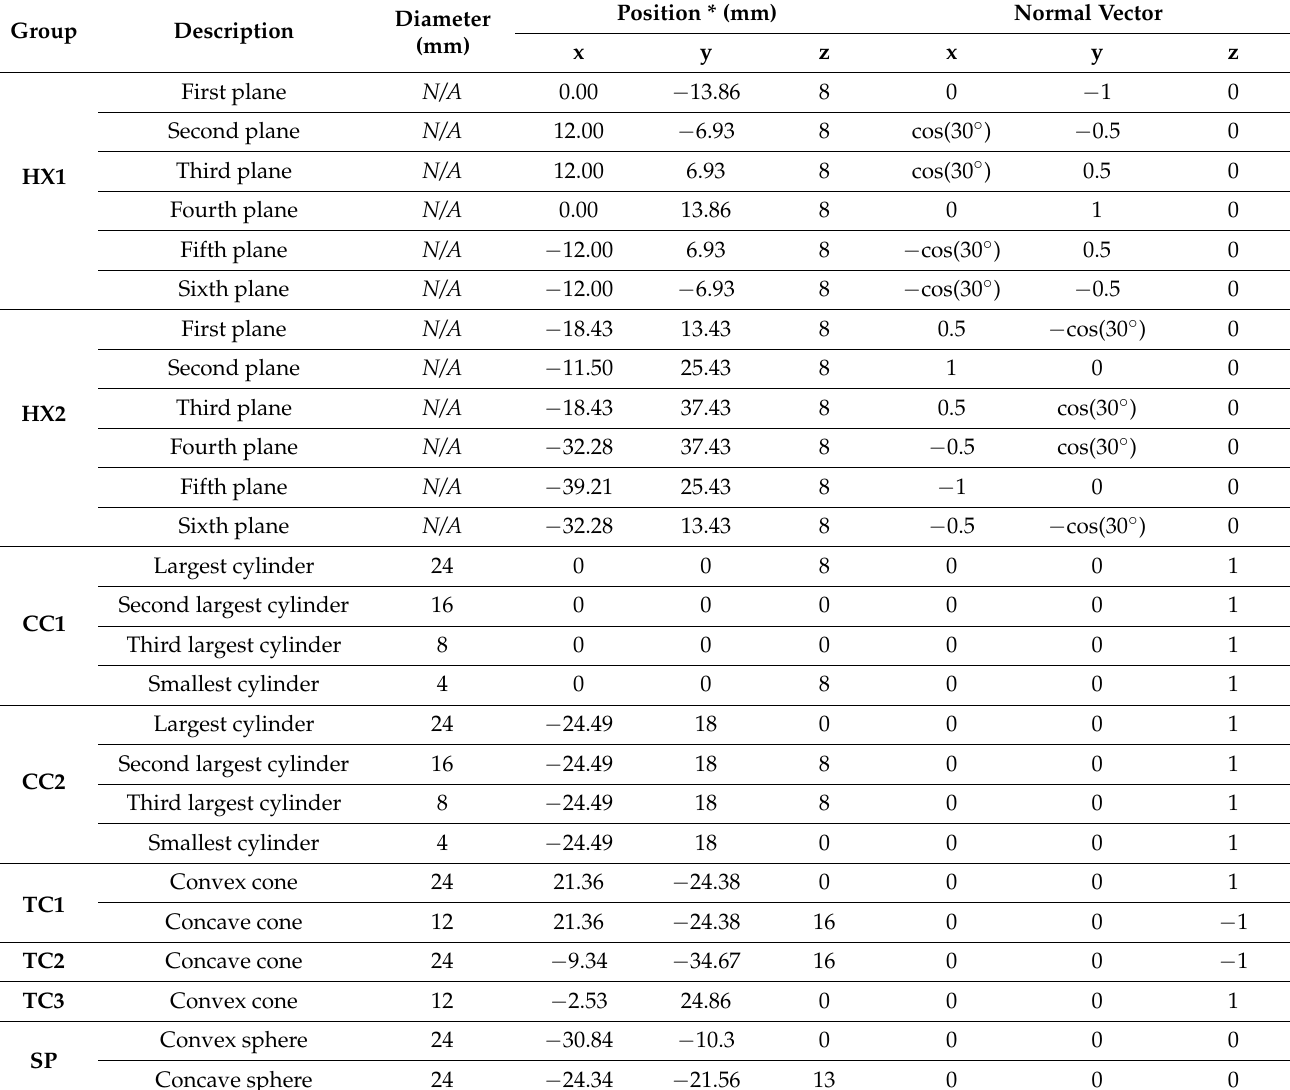
Table 2. Details on all shape features of the designed